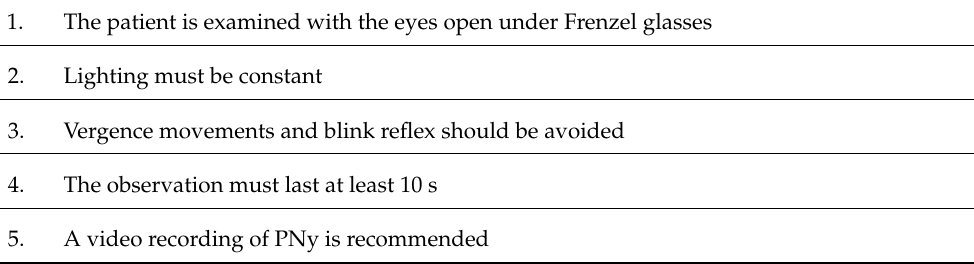
Table 3. The modalities of observation of